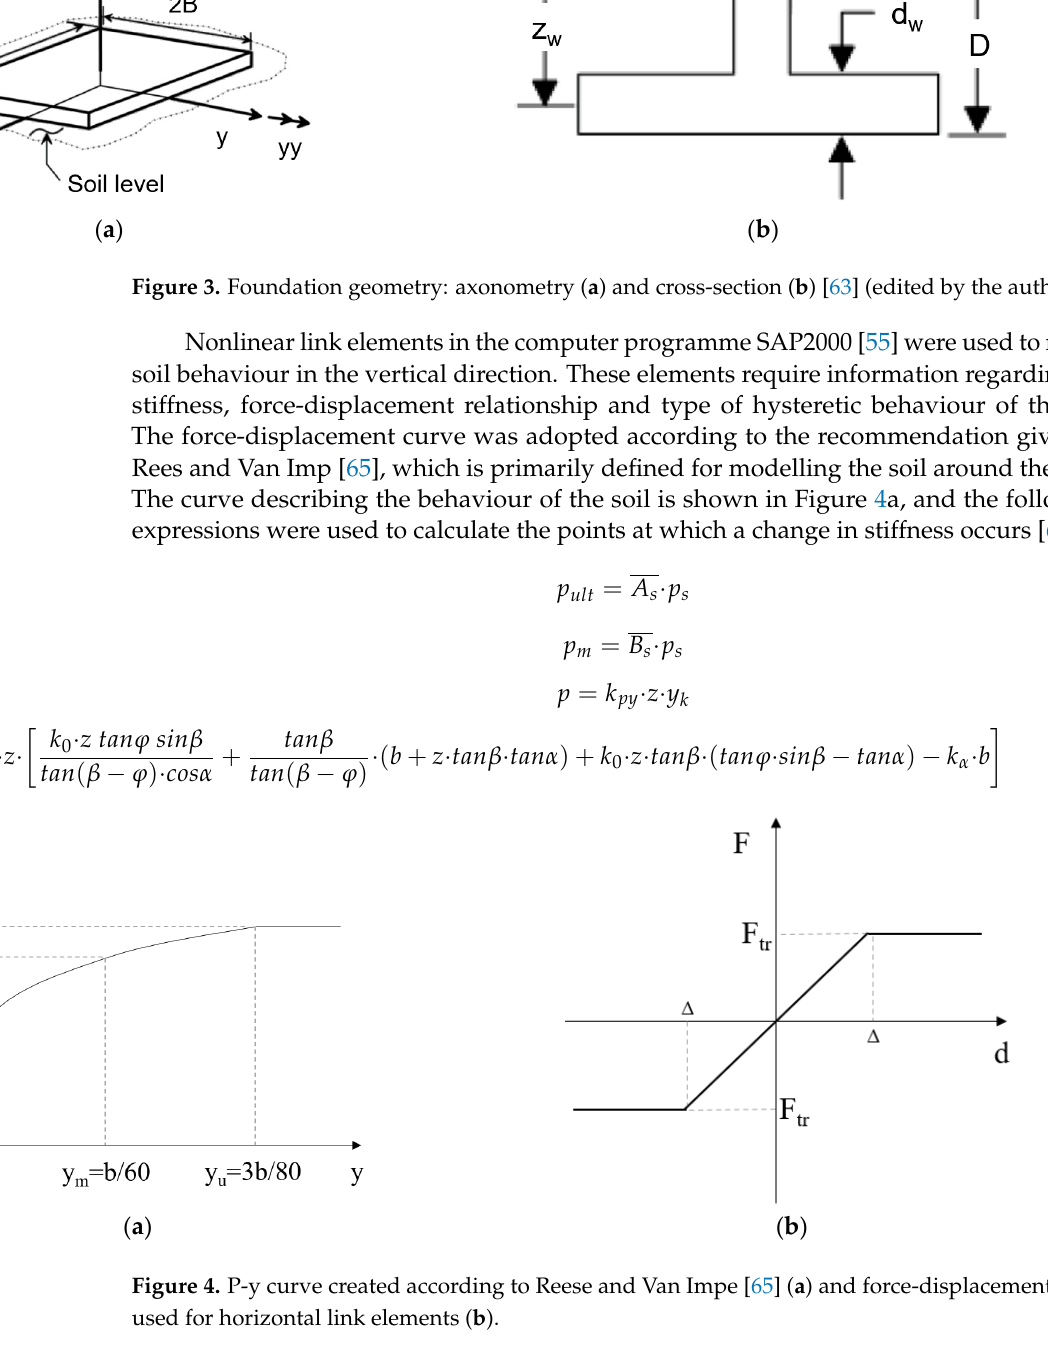
Figure 4. P-y curve created according to Reese and Van Impe [65] ( a ) and force-displacement curve used for horizontal link elements ( b ).